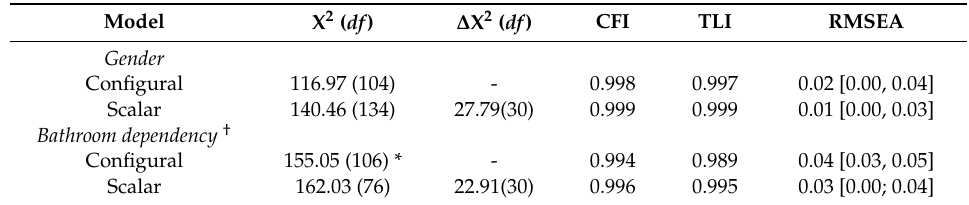
Table 2. Multigroup invariance exploratory structural equation modeling (ESEM) for the PBPS and gender and bathroom dependency groups.